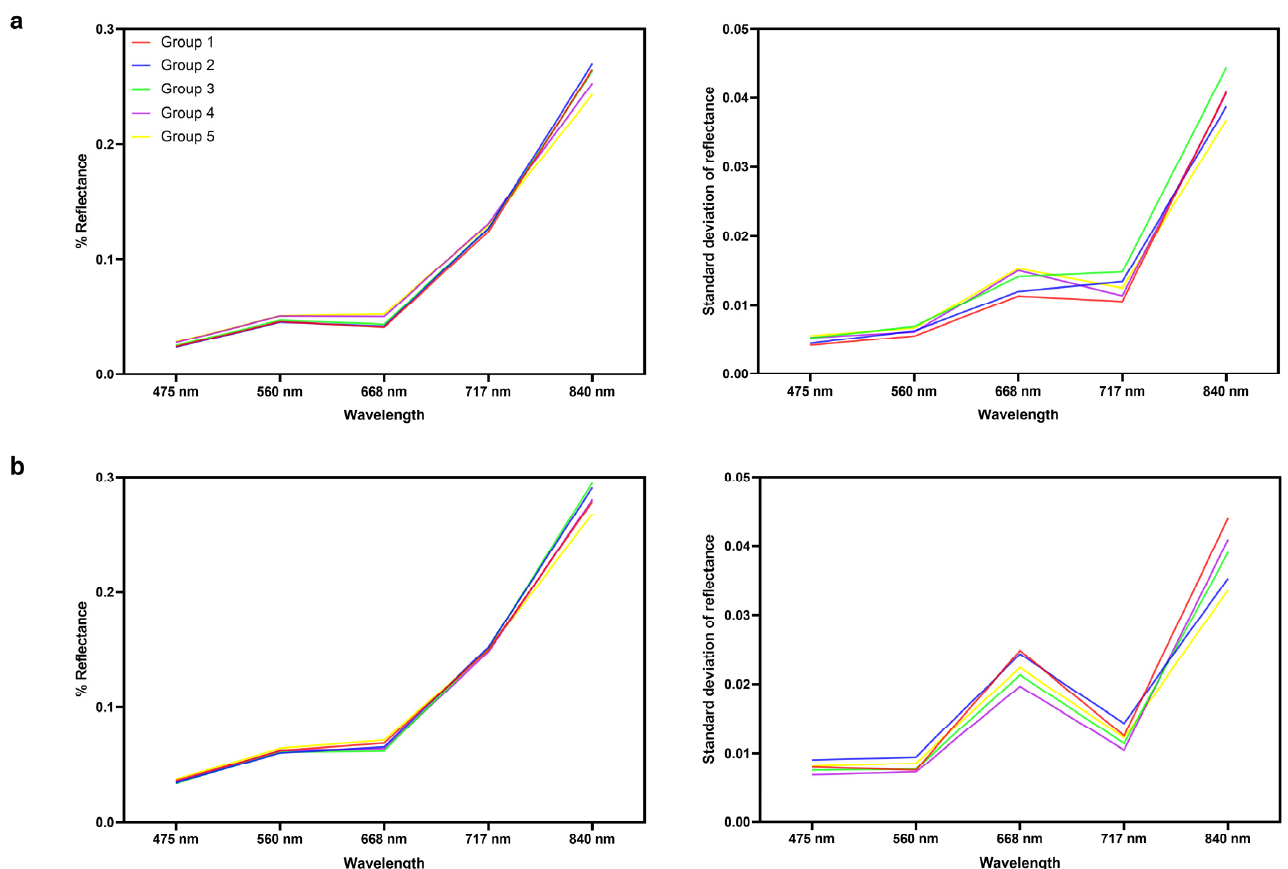
Figure 4. Reflectance variations of multispectral data among the five genotypic groups for ( a ) the early acquisition (17 May), and ( b ) the late acquisition (1 June). The right panels show the standard deviation of canopy reflectance.